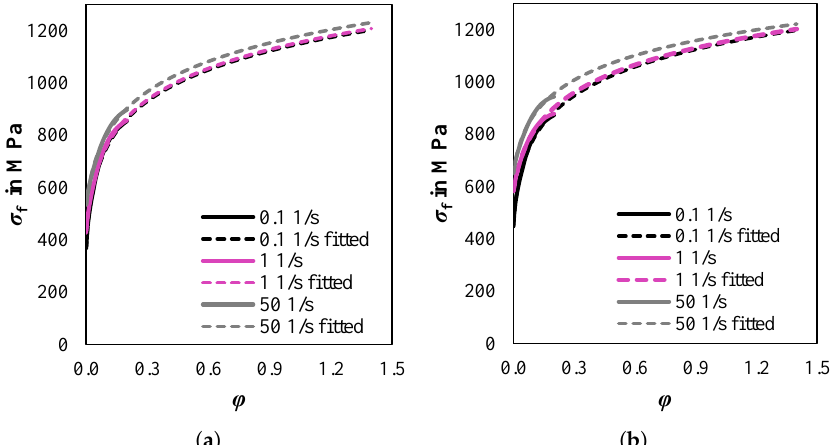
Figure 5. Experimental and extrapolated flow curves at room temperature determined by layer com- pression tests for hot strips with ( a ) a homogeneous microstructure and ( b ) a banded